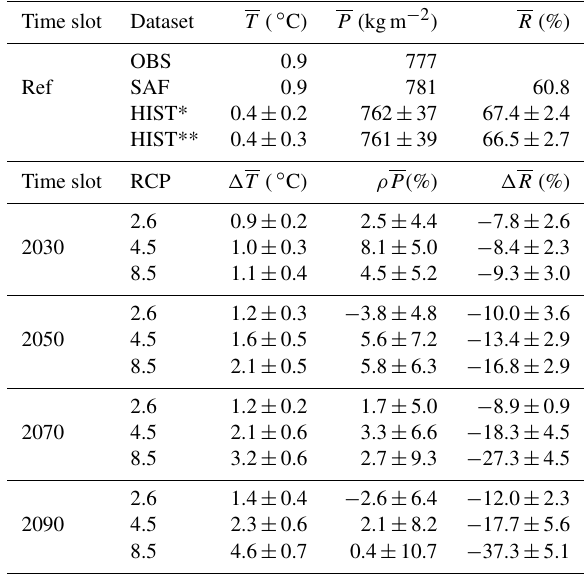
Table 3. Values for the mean ( µ ) ± σ (cid:48) of 15-year running means, for the reference period 1986–2005 (Ref) in observations (OBS, only µ ), SAFRAN-Crocus (S-C, only µ ) and historical scenario (HIST, * 13 GCM–RCM pairs, ** 4 GCM–RCM pairs correspond- ing to the ones in RCP2.6), and around the time slots 2030, 2050, 2070 and 2090 for each future scenario (RCP2.6: 4 pairs; RCP4.5 and RCP8.5: 13 pairs), for SD, (cid:91) SWE and SOD – SMOD (mm/dd – mm/dd; for RCPs, number of days earlier or later compared to HIST* SOD and SMOD).